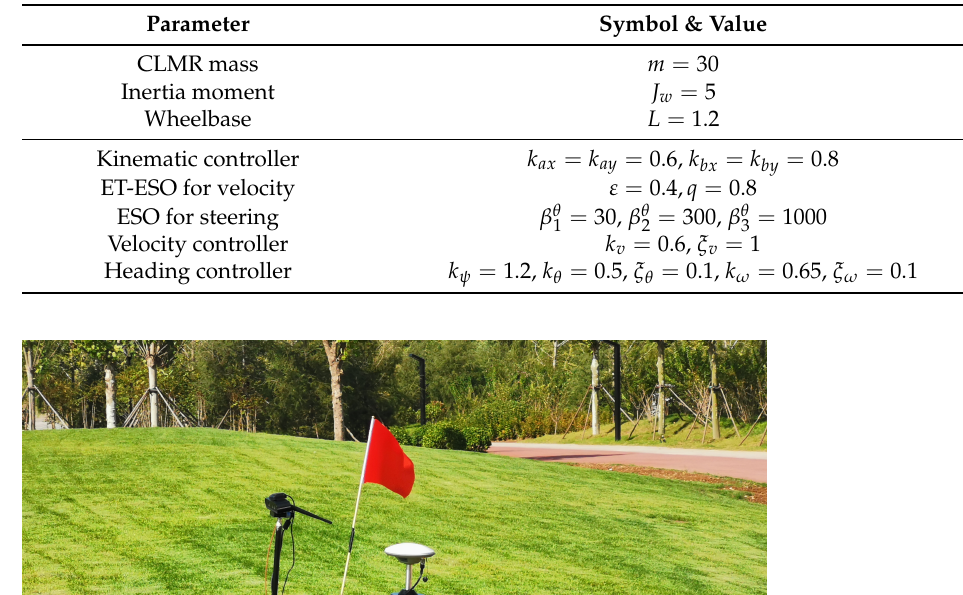
Table 1. CLMR and controller parameters.